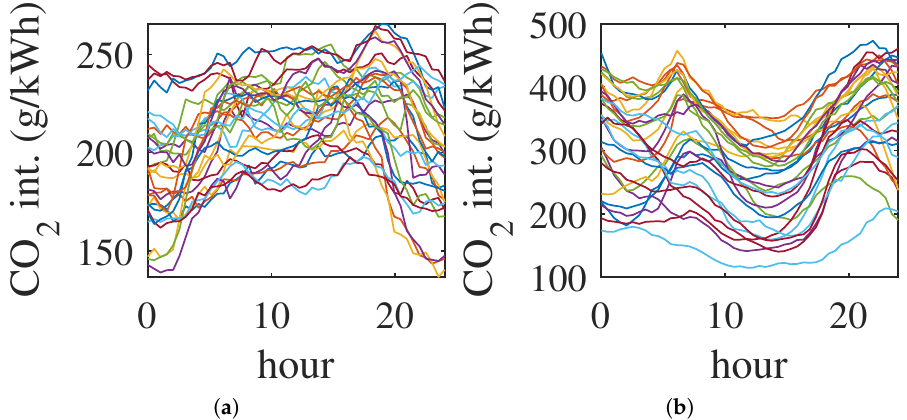
Figure 7. Daily profiles of carbon intensity for scenarios ( a ) NYISO and ( b ) DE-S. The influence of solar generation is clearly visible in the German